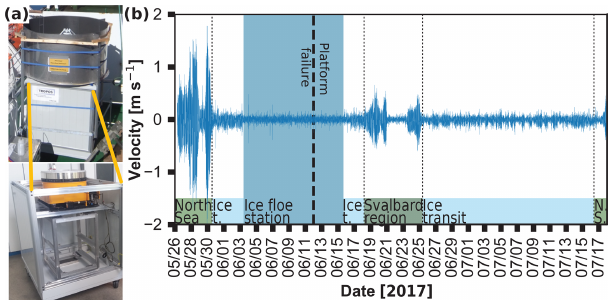
Figure 3. (a) The cloud radar aboard Polarstern and the stabiliza- tion platform. Panel (b) shows the time series of the cloud radar heave rate during PS106. The thick dashed vertical line indicates the moment when the stabilization platform had a malfunction. At the bottom, a rough localization of Polarstern is annotated – green: North Sea (N.S.); light blue: ice transit (Ice t.); dark blue: ice floe camp; dark green: Svalbard